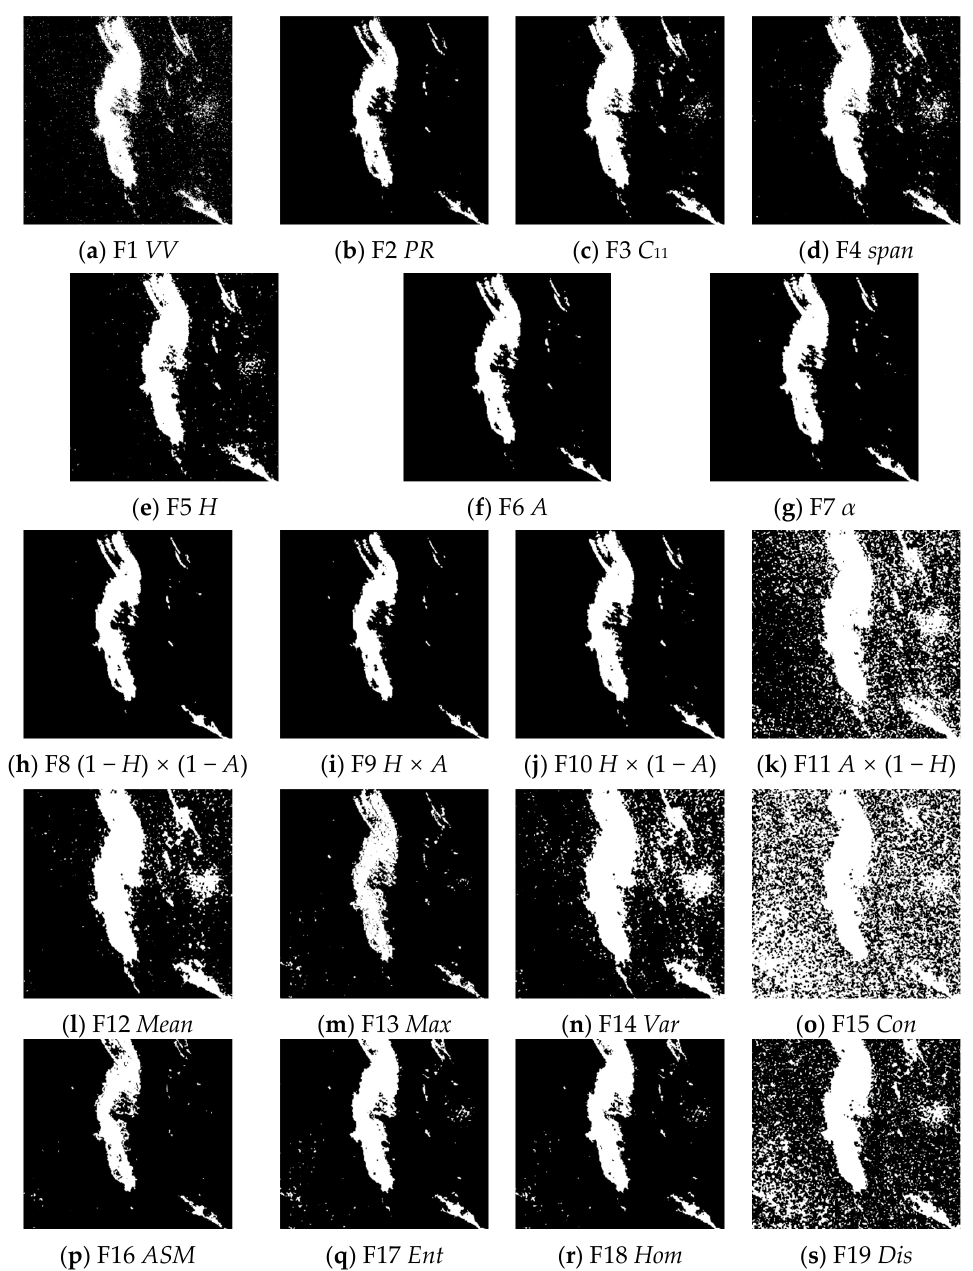
Figure 11. Image segmentation result for data b based on K-means algorithm.